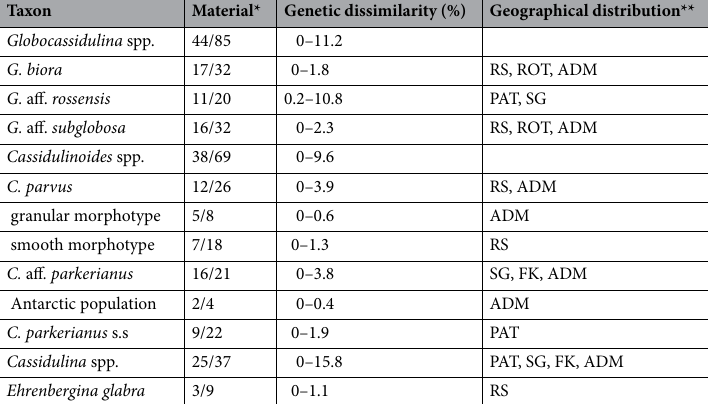
Table 1. Number of isolates/clones, genetic dissimilarity, and geographical distribution in different taxa of the Cassidulinidae family from the Southern Ocean. *Number of isolates (1st number) and clones (2nd number). **Antarctica: RS Ross Sea, WS Weddell Sea, ROT Rothera, Margarite Bay, ADM Admiralty Bay, South Shetlands, as well as PAT southern Patagonia, FK Falkland Islands, and SG South Georgia.